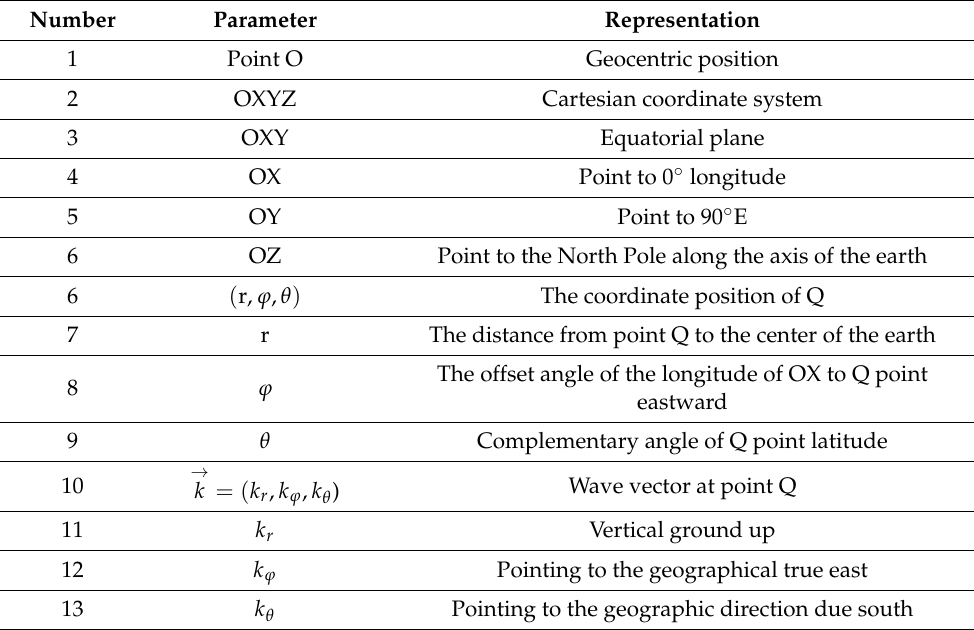
Figure 1. Schematic diagram of ray-tracing spatial coordinates. The meaning of each letter in Figure 1 is shown in Table 5. Table 5. The meaning of related parameters in the above Figure